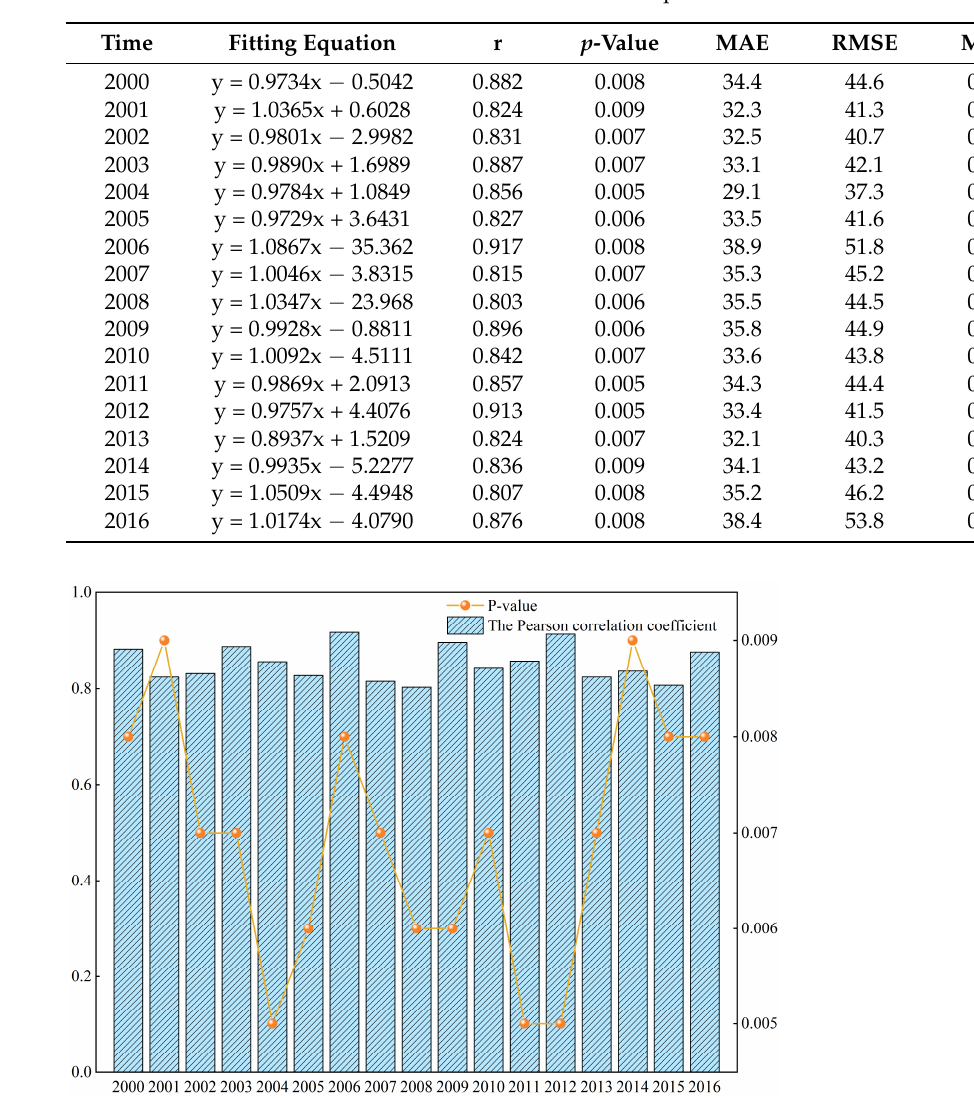
Figure 4. Error variation graph